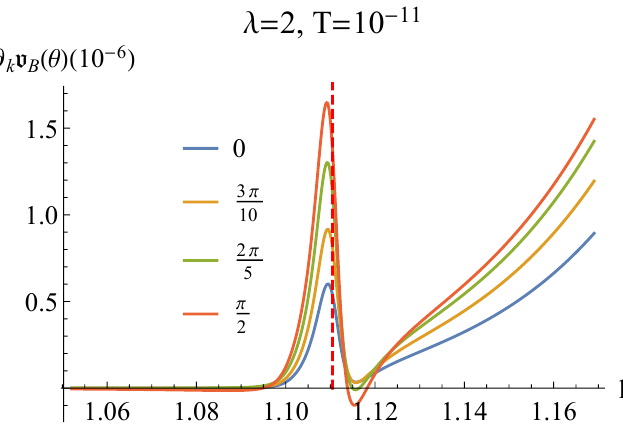
Figure 7 . @ k v B ( (cid:18) ) at di(cid:11)erent angles speci(cid:12)ed by the plot legends where the red vertical line represents the position of the critical